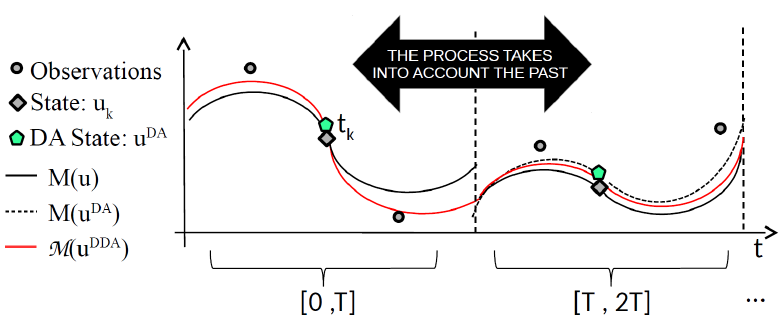
Figure 3. The Deep Data Assimilation (DDA)